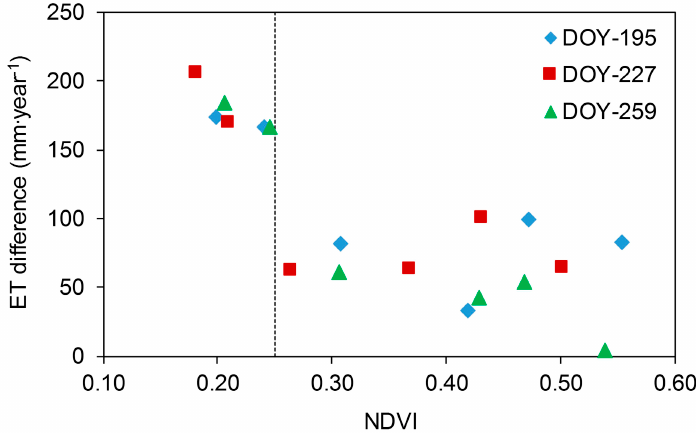
Figure 6. Evapotranspiration (ET) differences (SSS–RSEB) versus NDVI for the three DOYs in 2008. Each point represents a subarea within the CNWR.